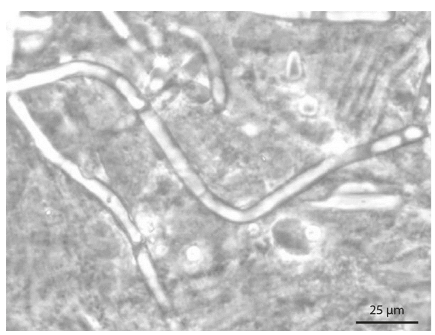
Figure 3: Candida hyphae ( × 1000 in patient’s saliva).